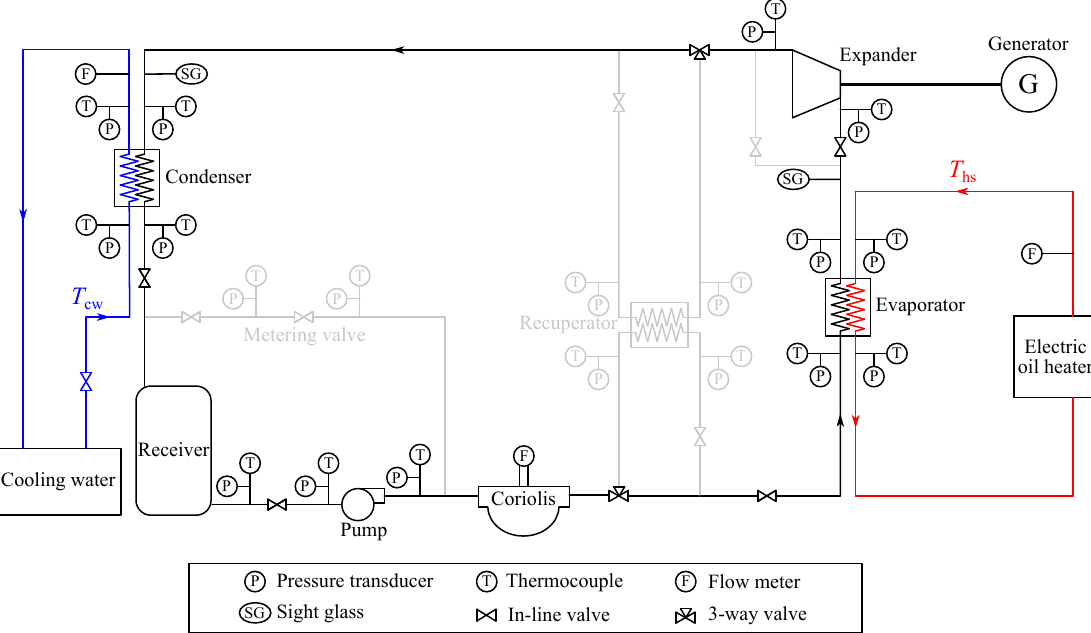
Figure 1. Piping and instrumentation (P&I) diagram of the organic Rankine cycle (ORC)